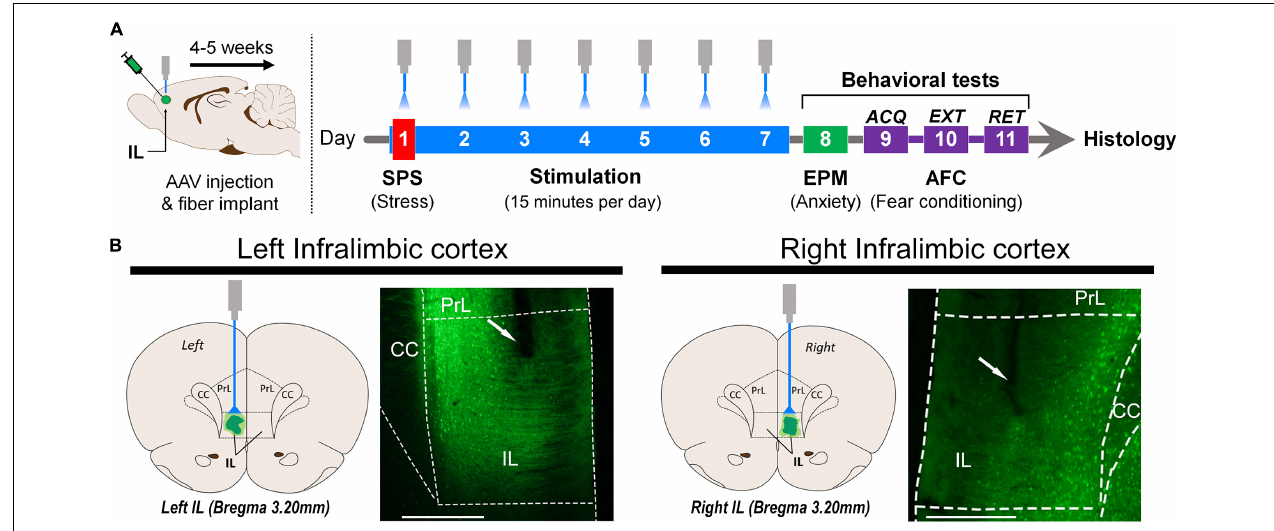
FIGURE 1 | (A) Schematic representation of the stereotaxic surgery for AAV virus injection and optical fiber implantation in the left or right infralimbic cortex (IL). Four to five weeks after surgical infusion of the virus, the single-prolonged stress (SPS) procedure was administered in 1 day. Optogenetic stimulation started 30 min after exposure to diethyl ether, and it was given for 15 min every day for 7 days. On day 8, elevated plus maze (EPM) behavior was tested for 5 min. Auditory fear conditioning (AFC): Acquisition (day 9) was followed by one extinction session (day 10). Retention was tested 24 h later (day 11). (B) Schematic representation of optical fiber implantation and representative photomicrograph of the left and right infralimbic portion of the medial prefrontal cortex (scale bar = 500 µ m). The area below the end of the optical fiber tract was exposed to light. ACQ, acquisition; EXT, extinction; RET, retention; Optical fiber tract (white arrow); PrL, prelimbic cortex; IL, infralimbic cortex; CC, corpus callosum.